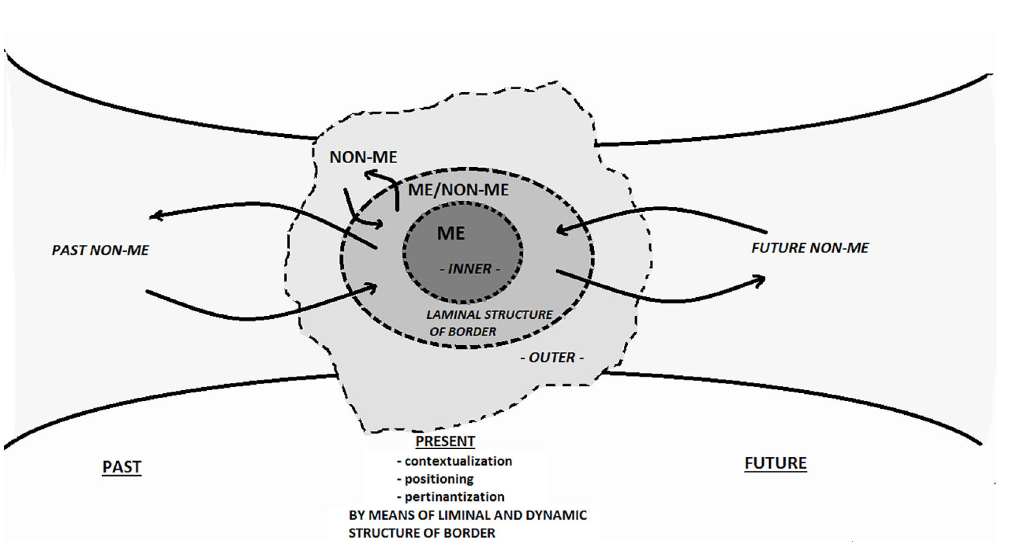
Figure 2. Liminal structure of the border of the self over